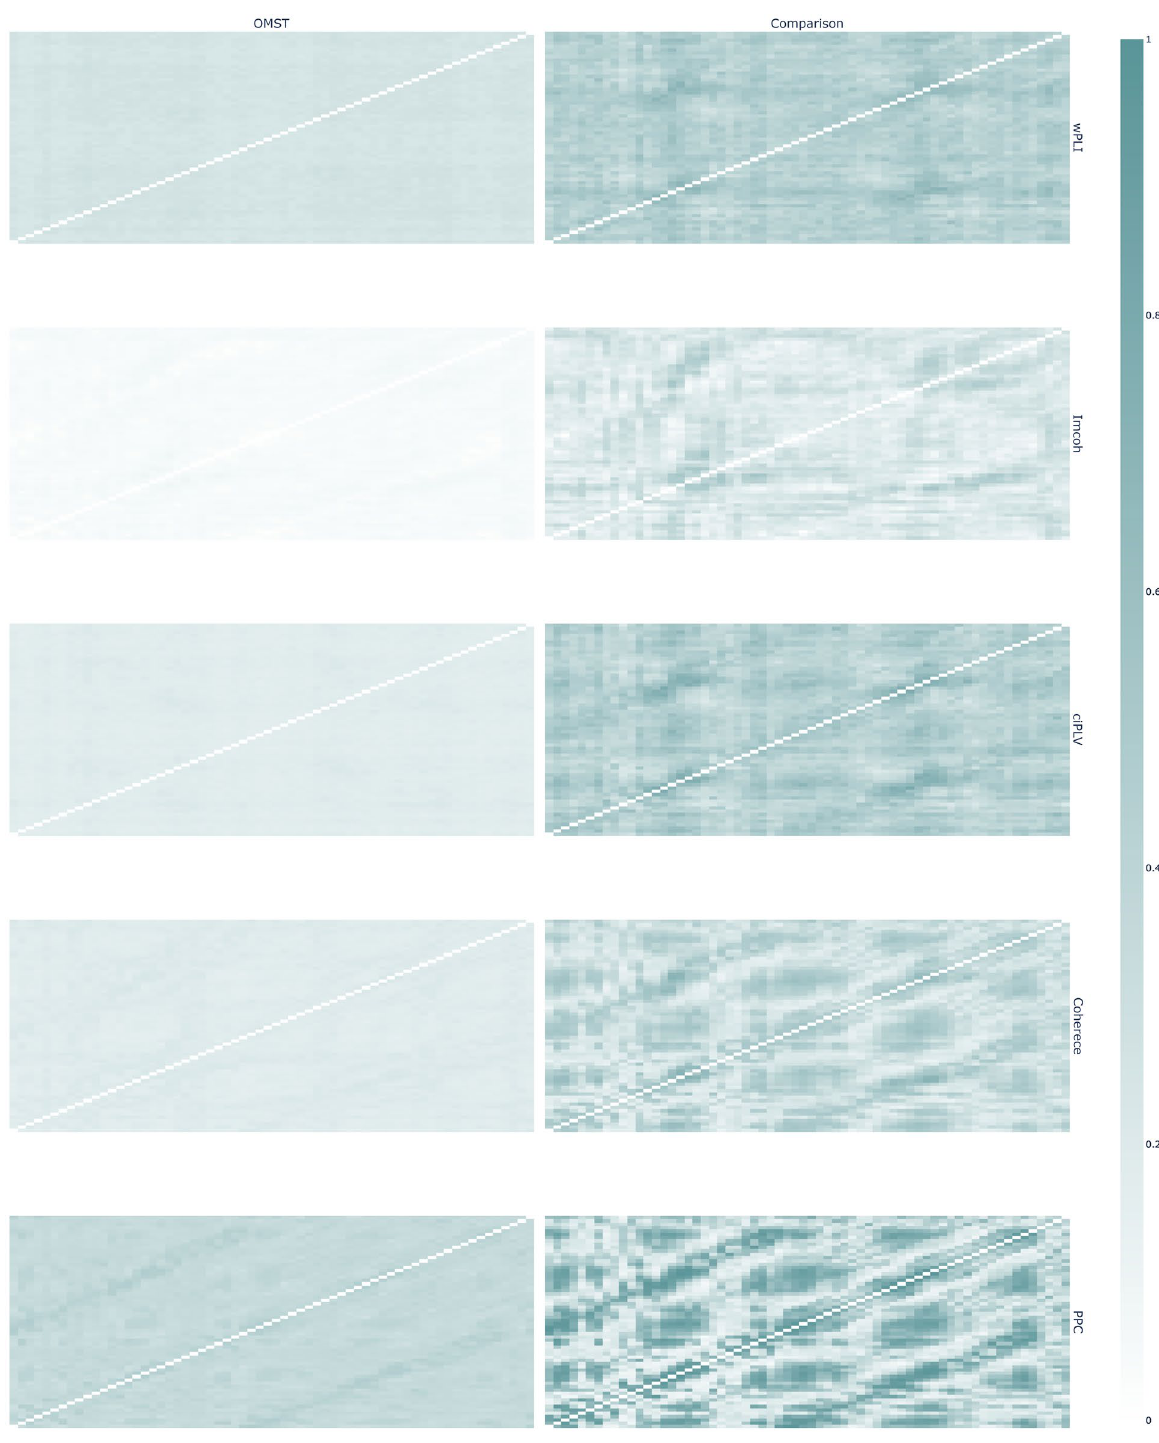
Figure 7. Graph structure for OMST-derived graphs and thresholded graphs of equal density in sensor space. The left column is OMST-derived networks, right—thresholded networks. The brightness of cells reflects the relative probability of edge existence. Brighter cells are more frequent in the individual networks in the sample. Synchronization measures by row: wPLI, Imcoh, ciPLV, coherence, PPC. Plotly 5.3.1 (https:// plotly. com/ python/) was used to create this